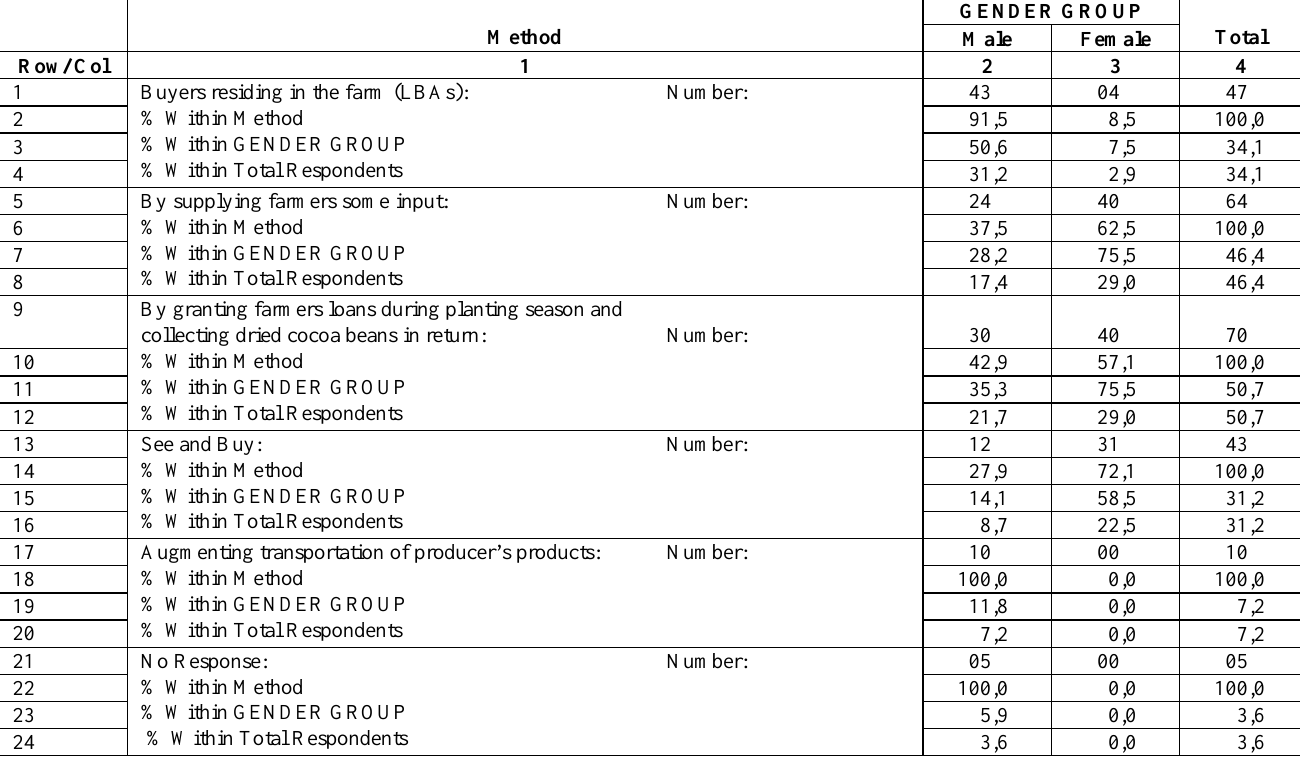
Table 10: Sources of marketed cocoa beans by marketers and by gender; Idanre, Ondo State of Nigeria. 2000/2001